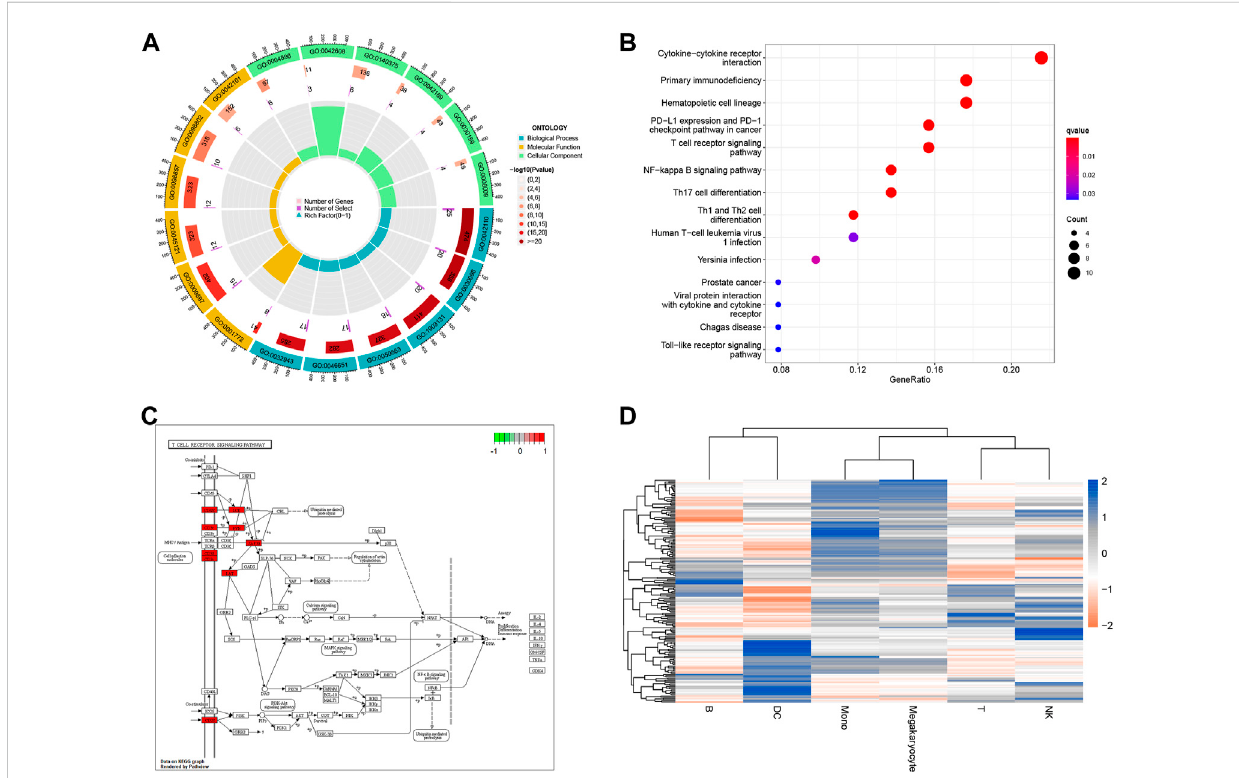
FIGURE 4 Enrichment analysis for immune-related genes and Single cell. (A) Chord plot for enrichment analysis of GO biological function. Blue, yellow and green respectivelyrepresentdifferentenrichmentfunctions,while red represents p -value. The darkerthecolor,thesmallerthe p -value. (B) Bargraphfor KEGG pathway enrichment analysis. The x-horizontal axis represents the proportion of enriched genes, and the color of the bar represents the p -value: theredderthecolor,thesmallerthe p -value,andthebluerthecolor,thelargerthe p -value. (C) DotplotforKEGGpathwayenrichmentanalysis.The X -axis represents the proportion of enriched genes, and the darker the color, the smaller the p -value. (D) Visualization of GSVA pathway for Single cell. Red squares represent negative correlation, blue squares represent positive